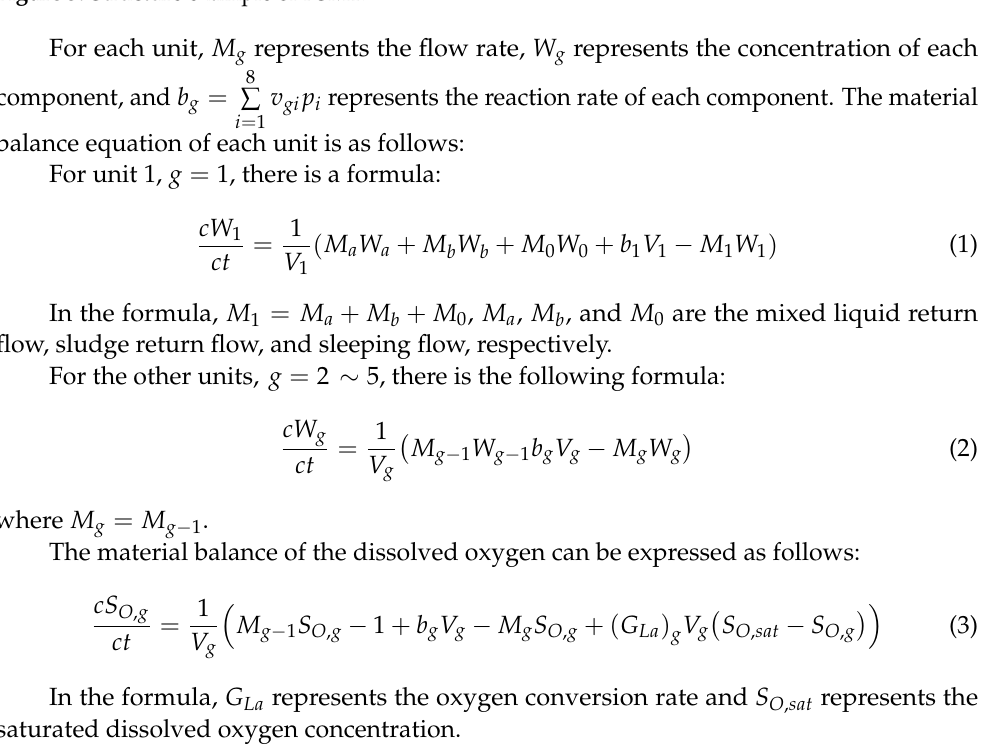
Figure 3. Structure example of BSM1.